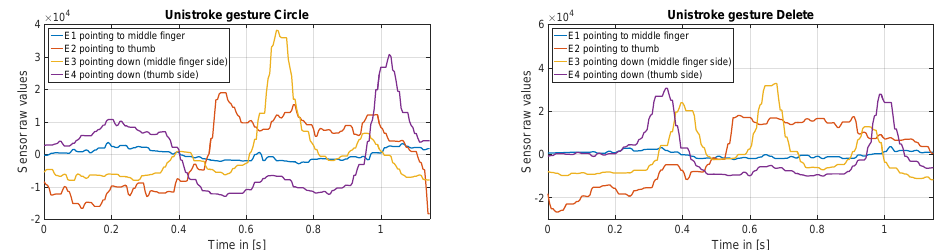
Figure 16. Raw values of the capacitive sensor for unistroke gestures Circle and